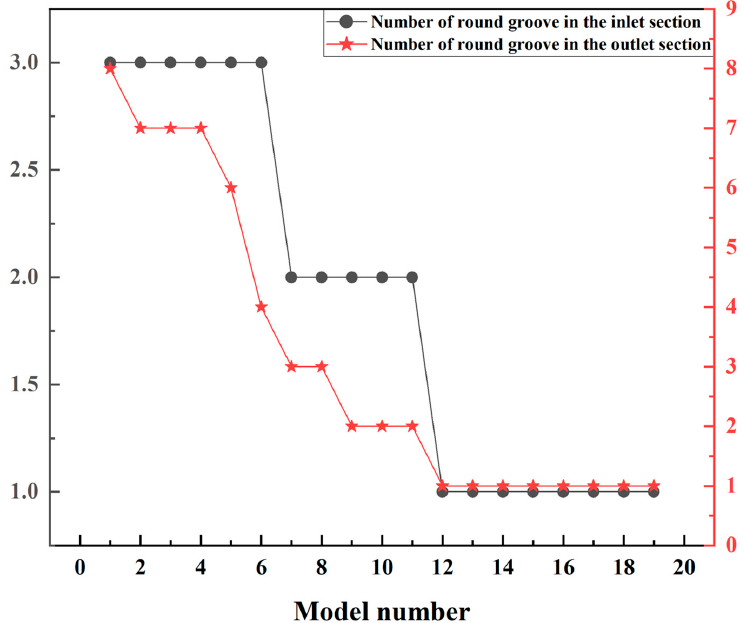
Figure 9. The number of circular ring grooves in the inlet and outlet sections.